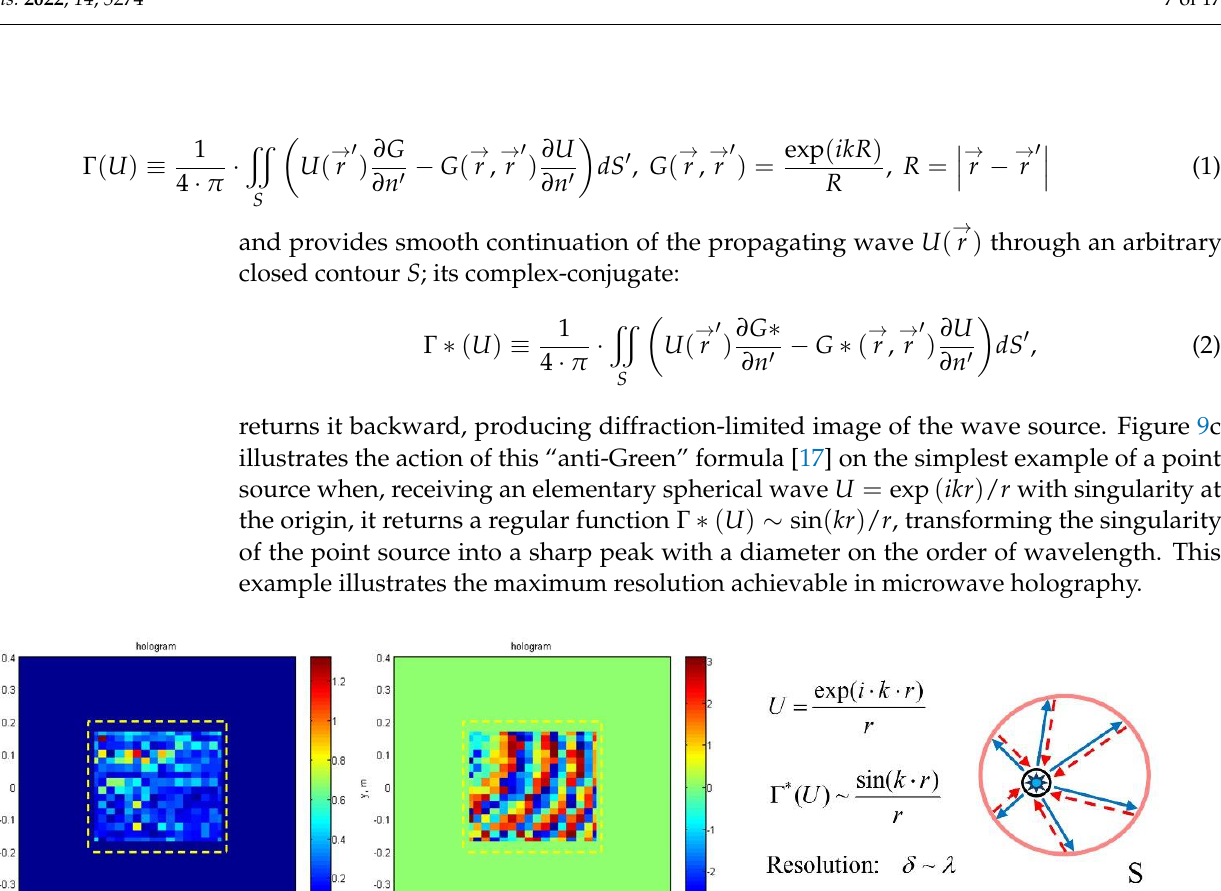
7 of 18 Figure 8. Schematic view of the experiment and HSR prototype.